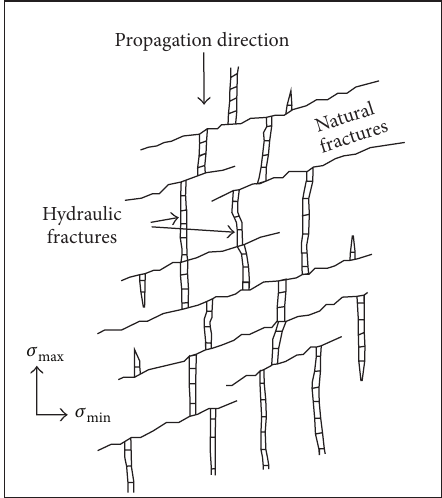
Figure 6: Visualization of far-field fracture network in fractured rock mass [4].